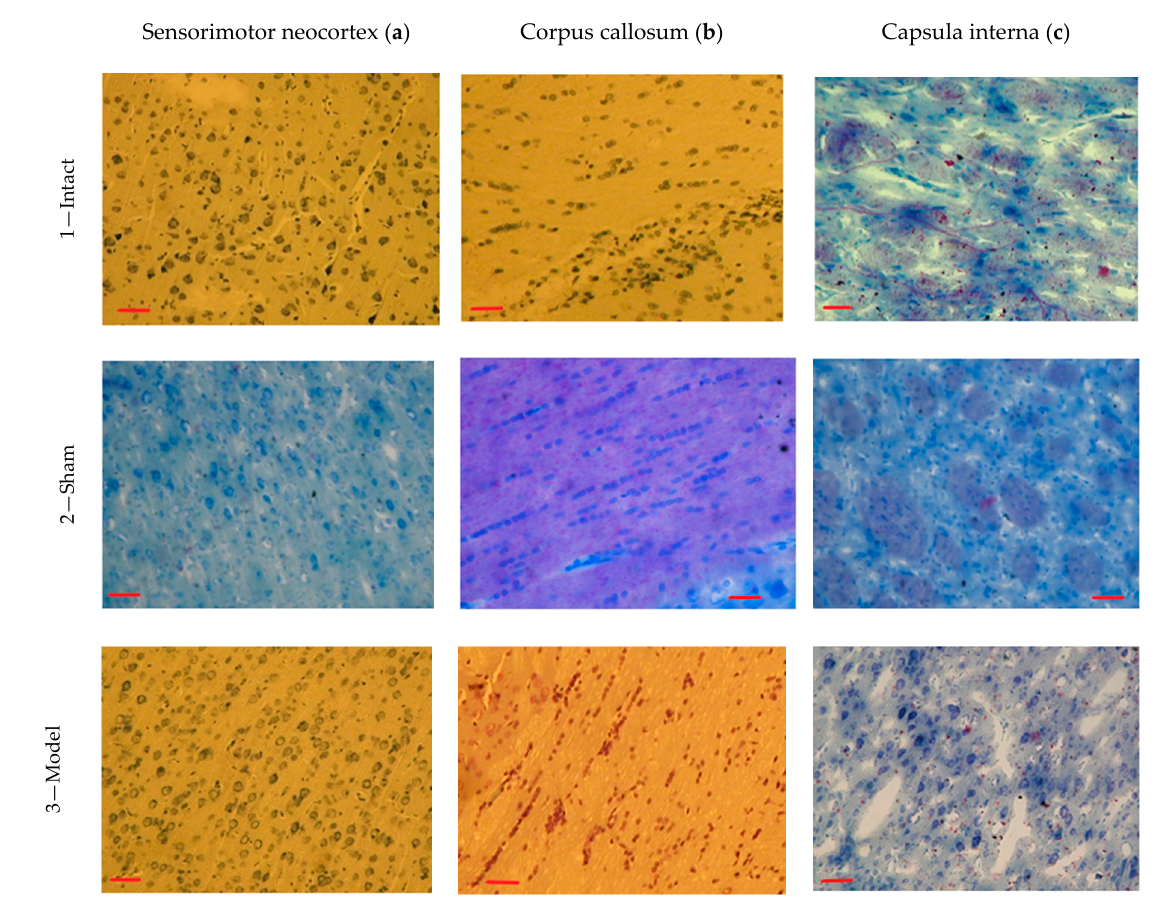
Figure 5. Histological brains structure (200×). Nissl/Hematoxylin–eosin staining. Scale bar 50 μ m.